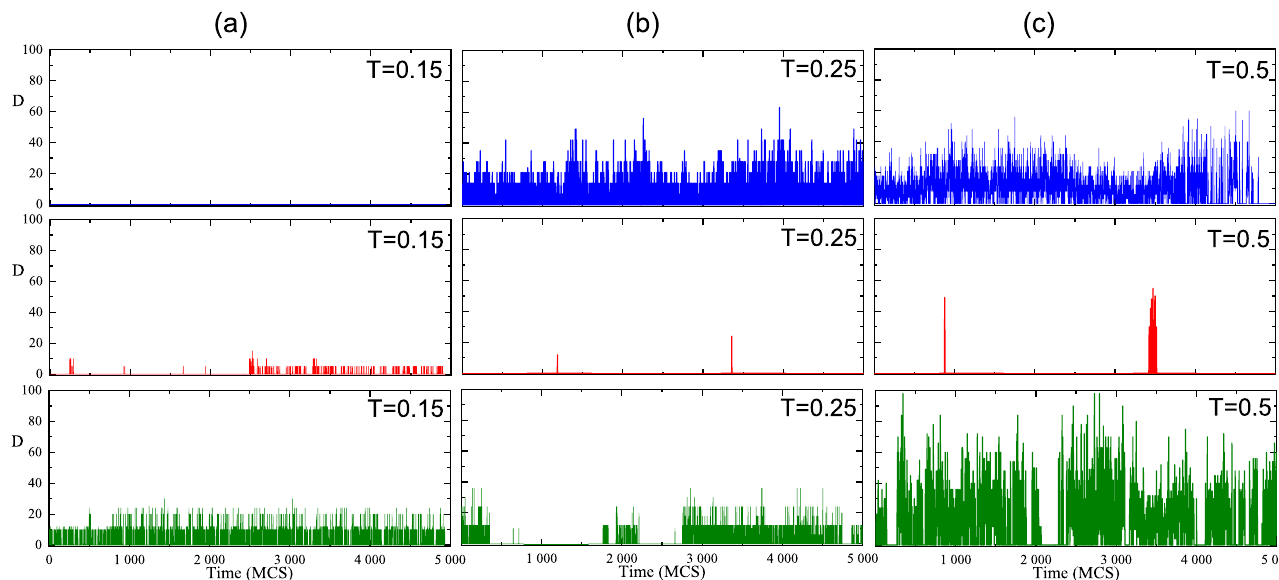
Figure 10. Time-dependence of parameter D in three representative cells for T = 0.15 ( a ), 0.25 ( b ) and 0.5 ( c ). The field D ( (cid:126) r , t ) is strongly inhomogeneous in space, see Figure 11, which shows